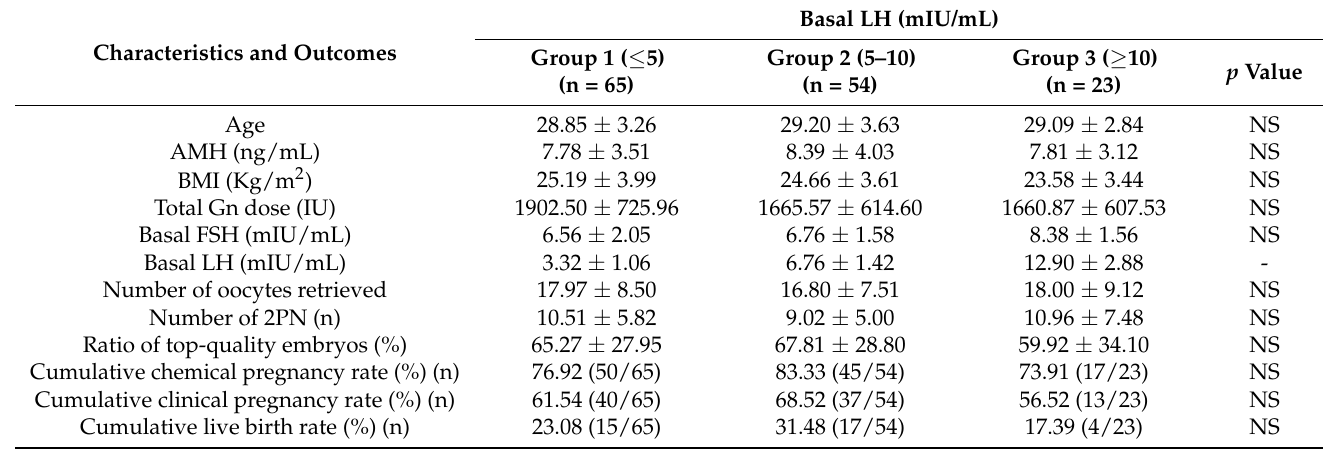
Table 2. Characteristics and outcomes of patients grouped by basal